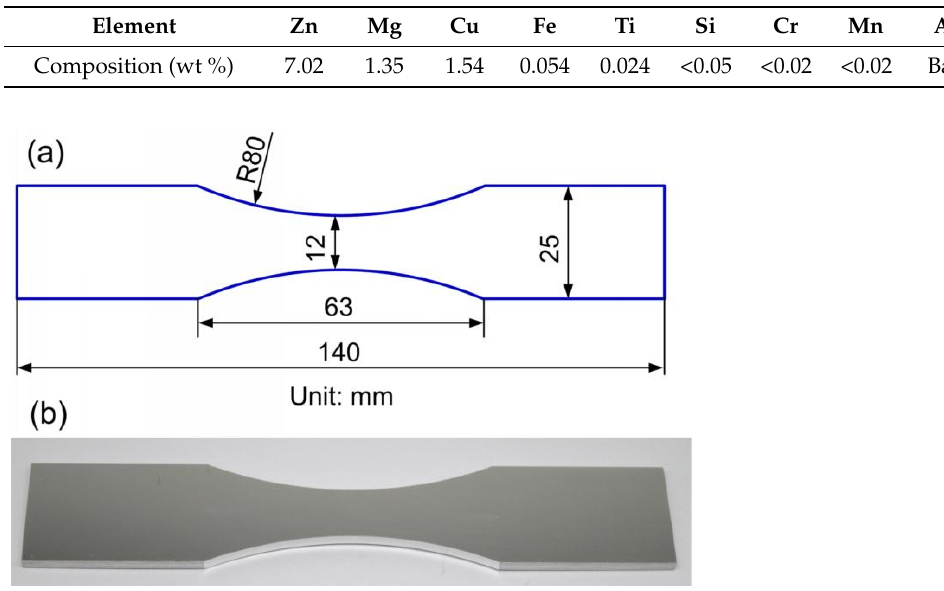
Figure 1. ( a ) Geometry and dimensions of the specimens; ( b ) surface morphology of the as-received 7085-T7452 aluminium alloy